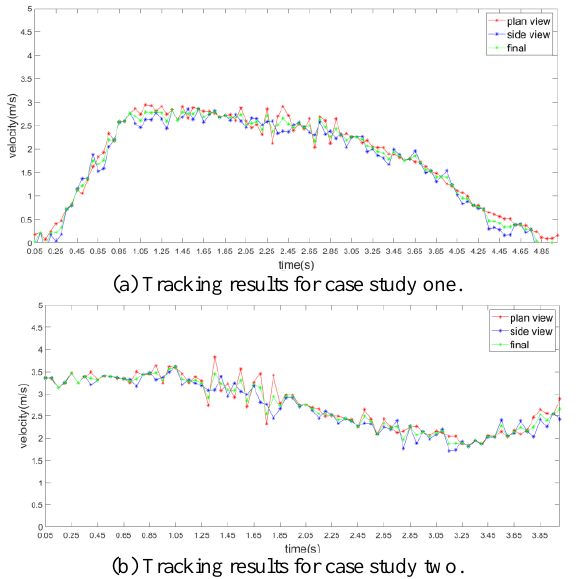
Figure 11. Tracking results for the two case studies.